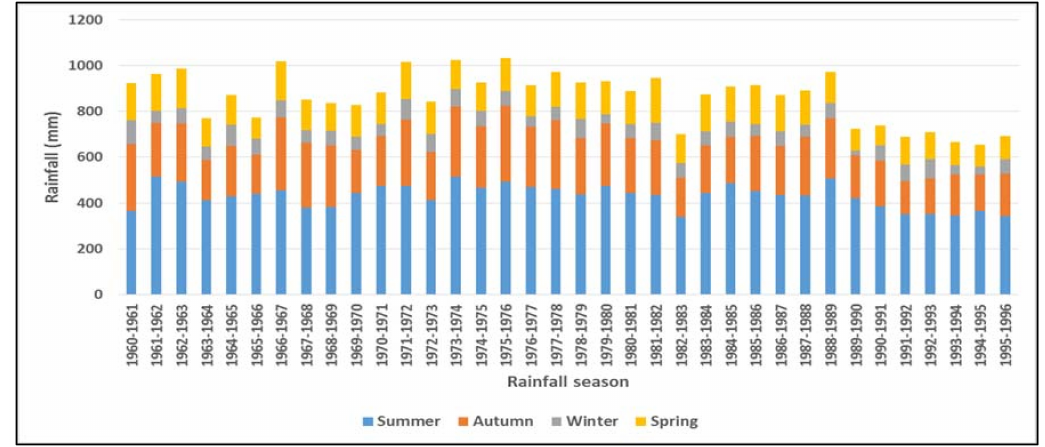
Figure 3. Historical changes in seasonal rainfall in the SADC region (1960 to 1996). Source: Nhamo et al.